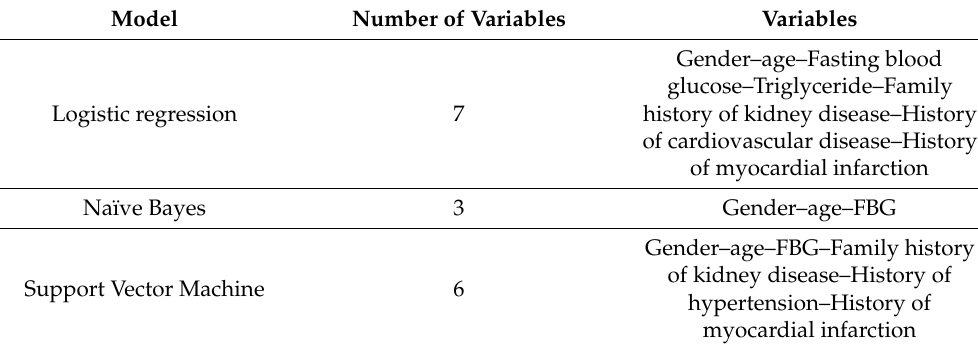
Table 2. The number of variables for each of the models.